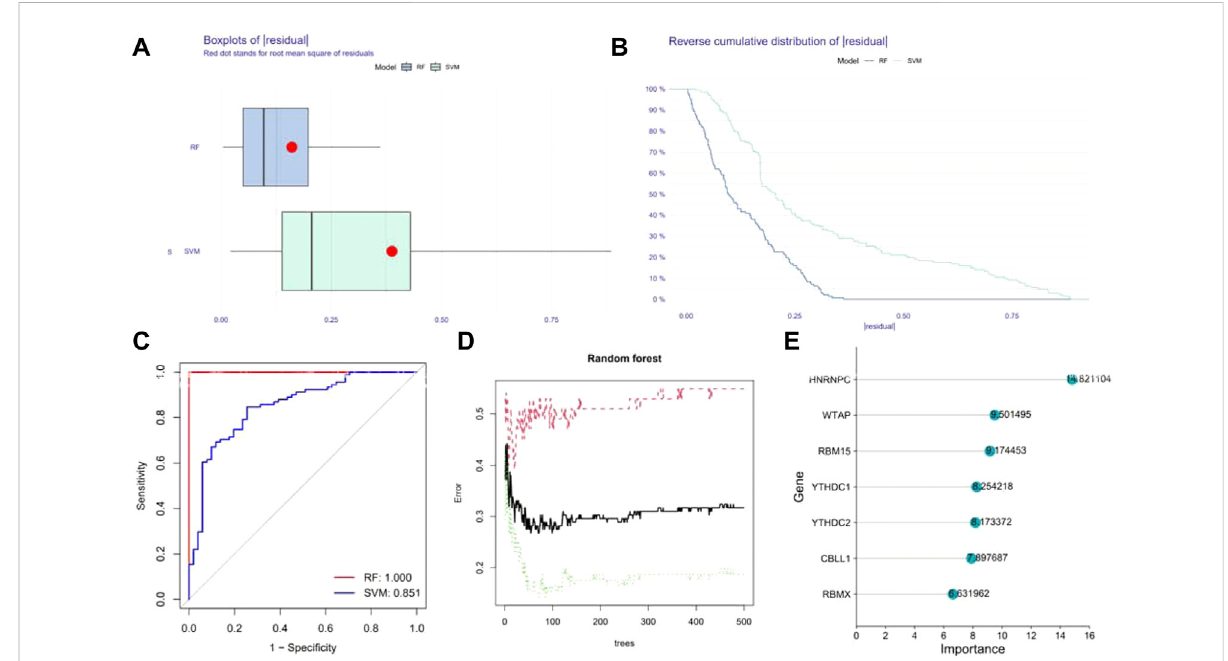
FIGURE 3 Construction of Random forest (RF) model. (A) The residual distribution of the RF and SVM model. (B) Reverse cumulative distribution of the residual of the RF and SVM model. (C) Receiver Operating Characteristic (ROC) curves verifying the accuracy of the RF and SVM model. (D) Correlation between the error and number of trees of non-epilepsy individuals, patients with epilepsy, and both. (E) The score of the importance of seven signi fi cant m6A regulators using the RF model (importance >